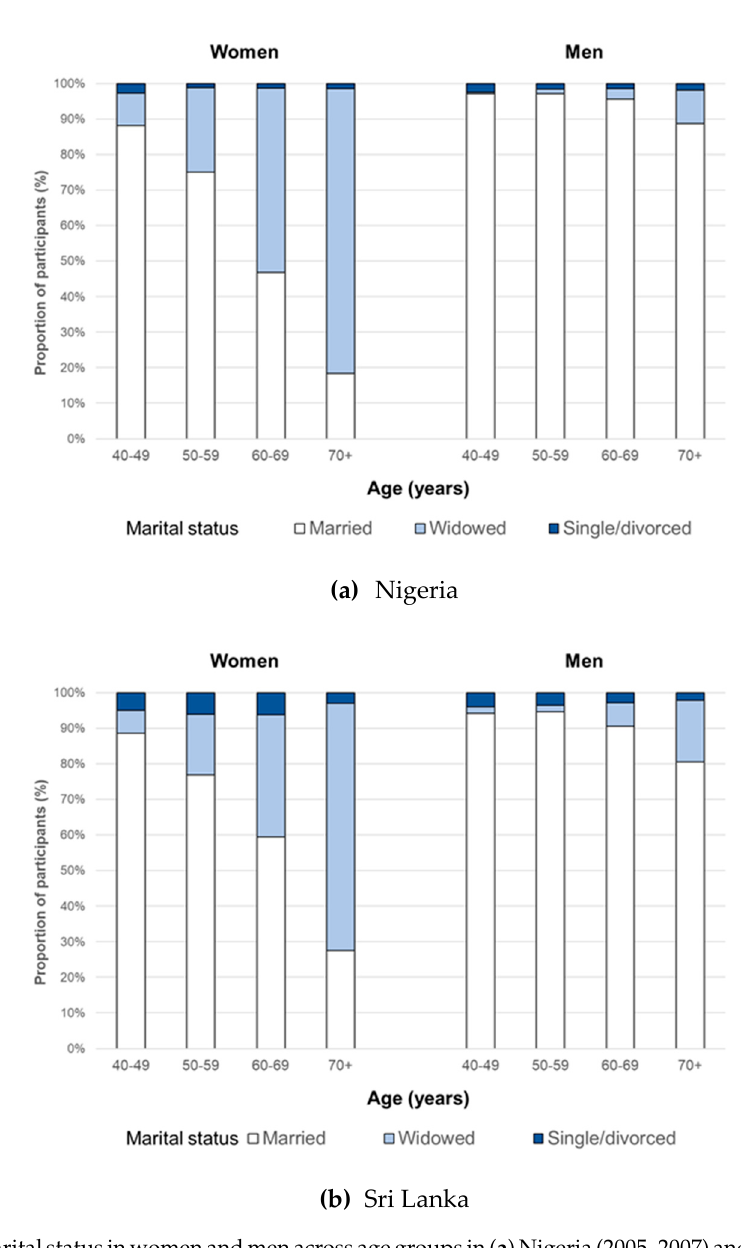
Figure1. Maritalstatusinwomenandmenacrossagegroupsin( a )Nigeria(2005–2007)and( b )SriLanka Figure 1. Marital status in women and men across age groups in ( a ) Nigeria (2005–2007) and ( b ) Sri Lanka (2012–2014).